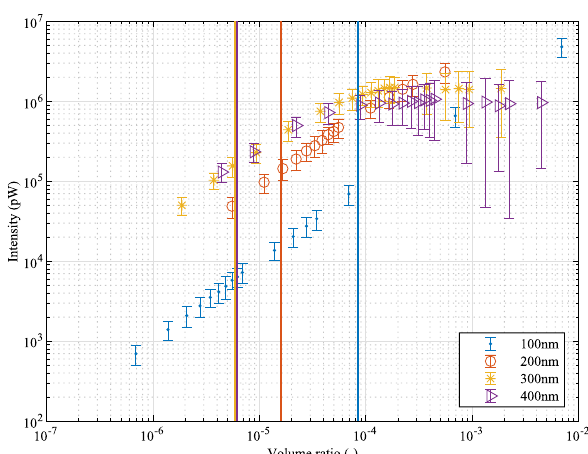
Figure 7. Intensity of backscattered light under different volume ratios of the NPs with 0.1069 cm gauge length. The blue, red, orange and purple lines show the maximum volume ratios in the case of single scattering for 100 nm, 200 nm, 300 nm and 400 nm respectively. (Incident light power 1 mW